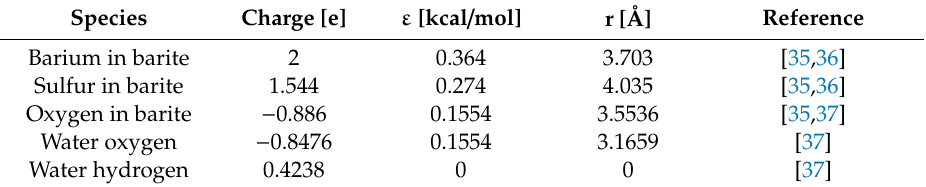
Table 2. Parameters for barite with lauryl phosphate